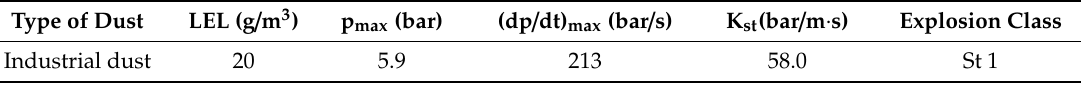
Table 4. The combustible dust characteristics of industrial dusts.